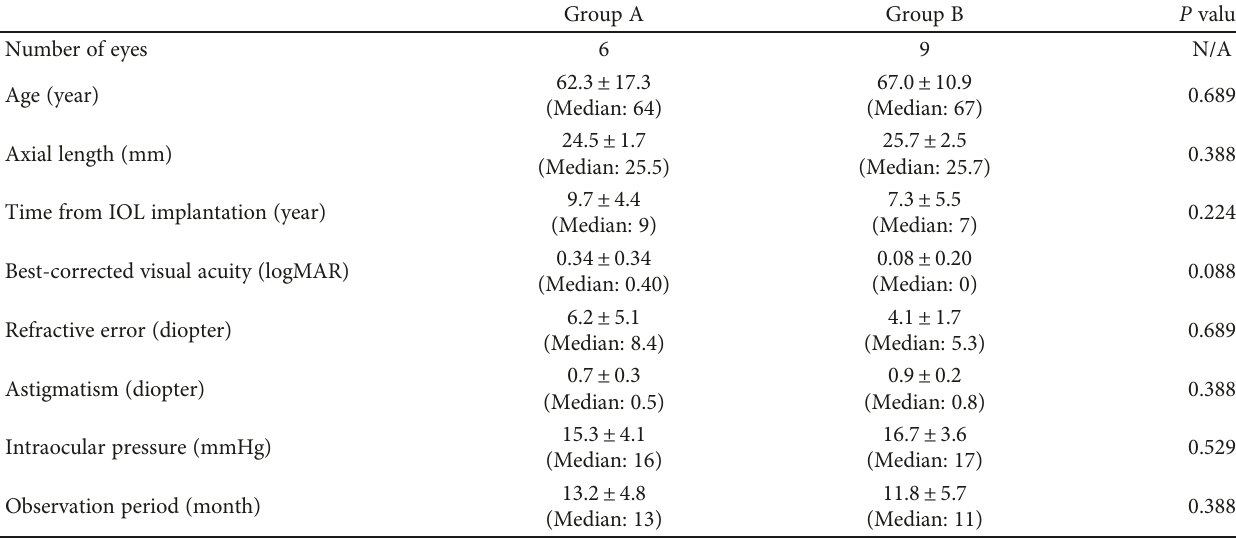
Table 1: Patient demographics at the baseline.